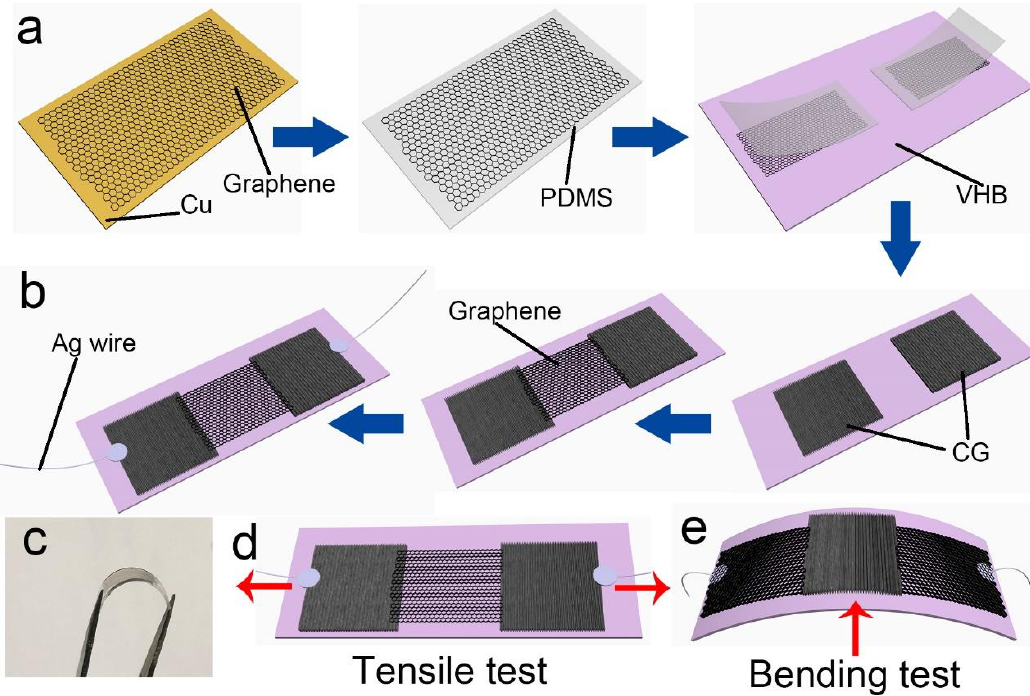
Figure 1. Schematic diagram of the fabrication process of the highly sensitive and stretchable strain sensor. ( a ) The transfer printing of graphene. ( b ) The fabrication process of a strain sensor. ( c ) Photograph of the flexible device. ( d ) Schematic diagram of the strain sensor under tensile testing. ( e ) Schematic diagram of the strain sensor under bending testing.